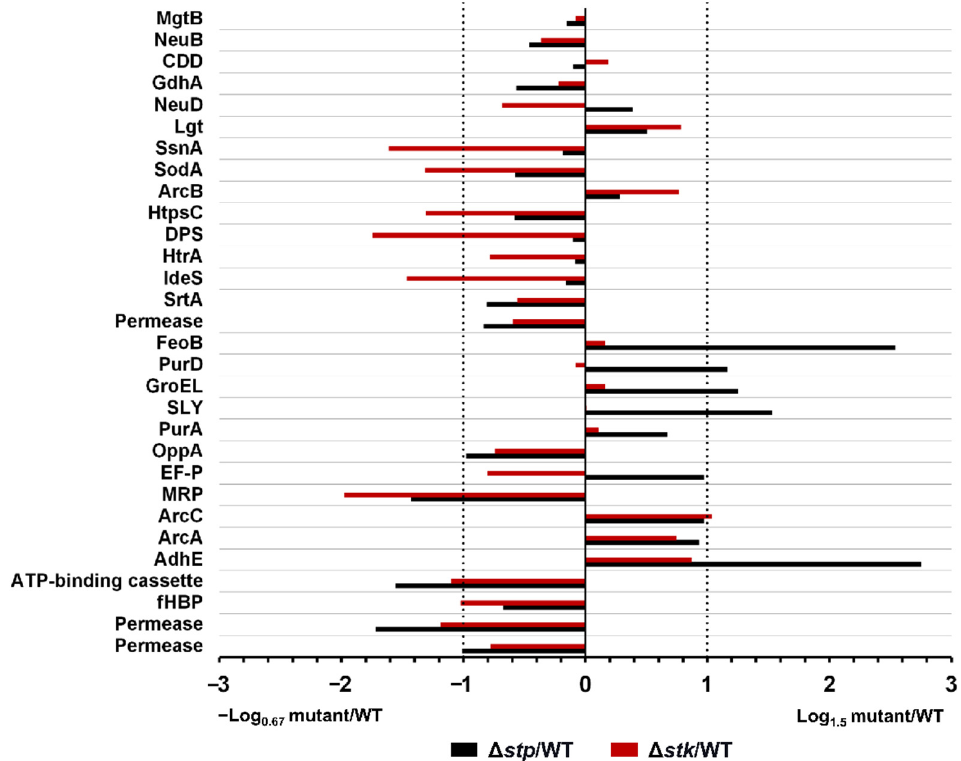
Figure 7. Expression of the virulence factors in Δ stp and Δ stk strains. The abundance of each indi- cated virulence factor in Δ stp or Δ stk strain was compared with that in WT, respectively. The proteins listed on the Y-axis are virulence factors of S. suis , and the numbers on the X-axis indicate the relative expression level compared with the WT strain. Fold change > 1.5 and p < 0.05 was regarded as significantly different.